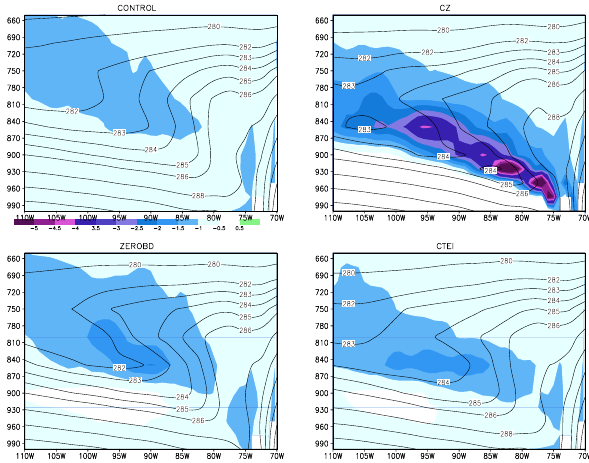
Fig. 14. As in Fig. 10 except for radiative heating rate (K/day) (shaded).